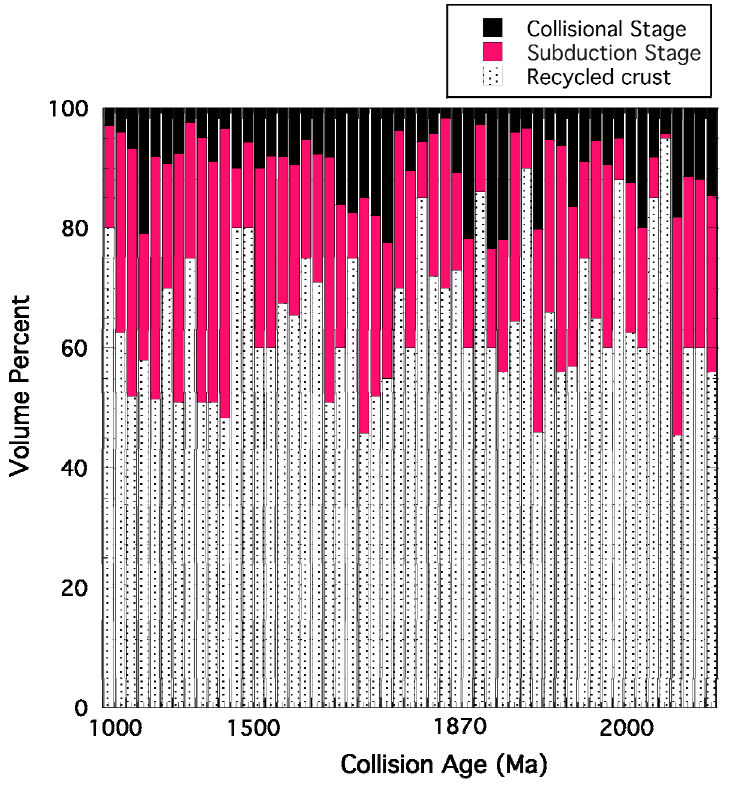
Figure 14. Fractions of juvenile and recycled crust preserved in Proterozoic orogens (data from Appendix 1). Juvenile crust divided into collisional and subduction stages of production. Mean values (%) and standard deviations: collisional 10, 6; subduction 25, 11; recycled 65, 12.